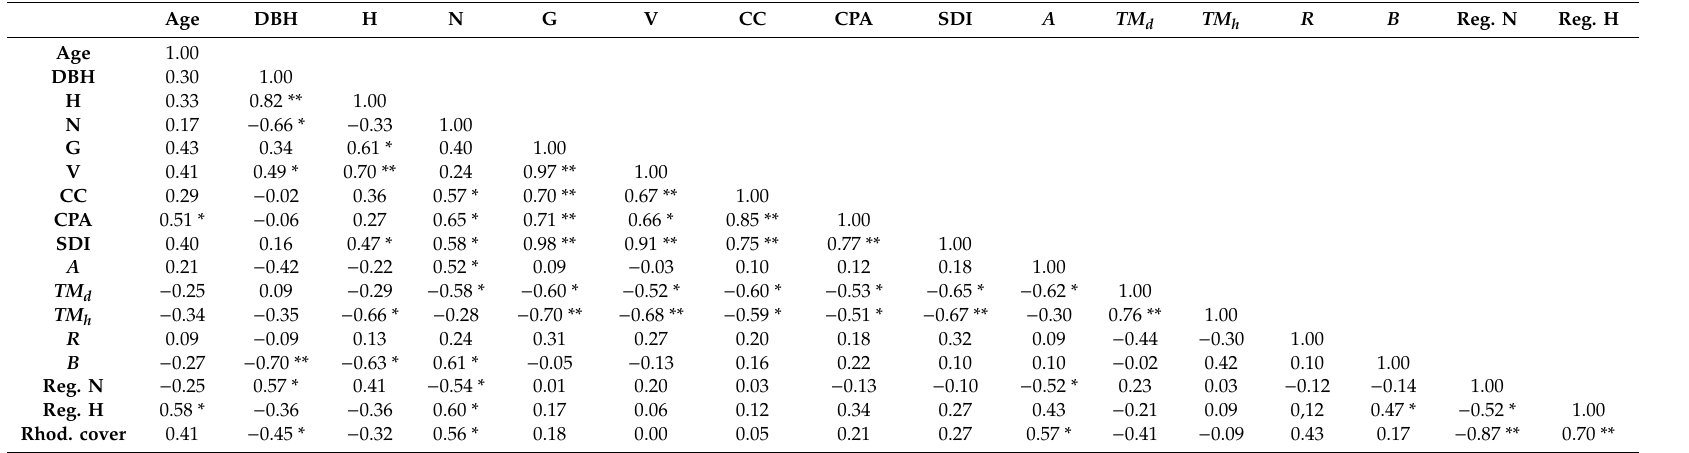
Table 8. Correlation matrix describing relationships between stand parameters (Age, DBH, H, N, G, V, CC, CPA, and SDI), diversity indices of tree layer ( A , TM d , TM h , R , and B ), natural regeneration parameters (Reg. N and Reg. H) and rhododendron cover (Rhod.